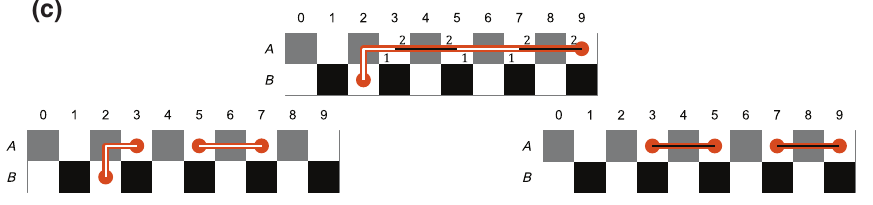
FIG. 8. (a) For segments marked in white, we use long-range Bell pair preparation in depth 2. (b) For seg- ments marked in black, we then use long-range Bell pair measurement in depth 2. (c) The Bell measurements in stage 2 stitch together the Bell pairs made in phase 1, resulting in a Bell pair in the qubits at the ends of the full path.